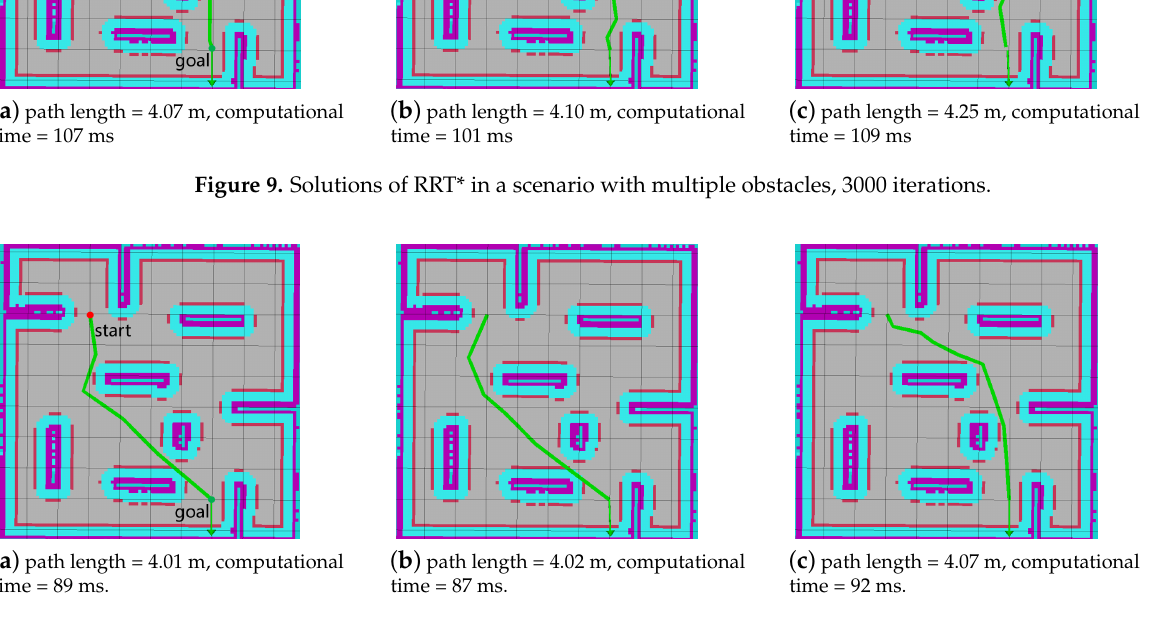
Figure 10. Solutions of BIT* in a scenario with multiple obstacles, 1600 iterations.